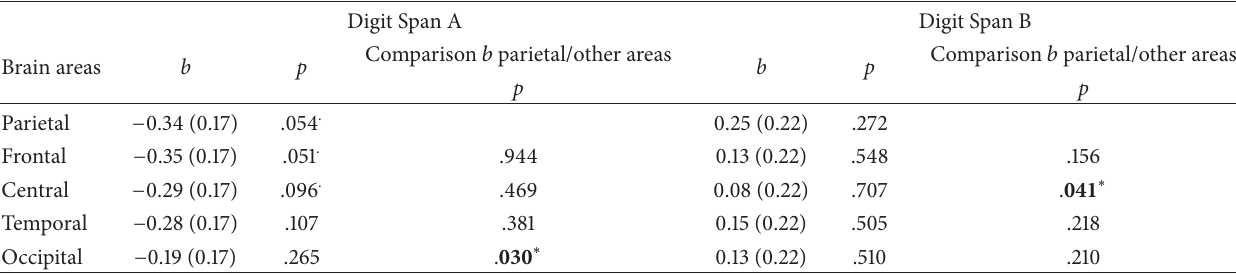
Table 6: Correlation between alpha/theta ratio and verbal Digit Span forward. Digit Span A Digit Span